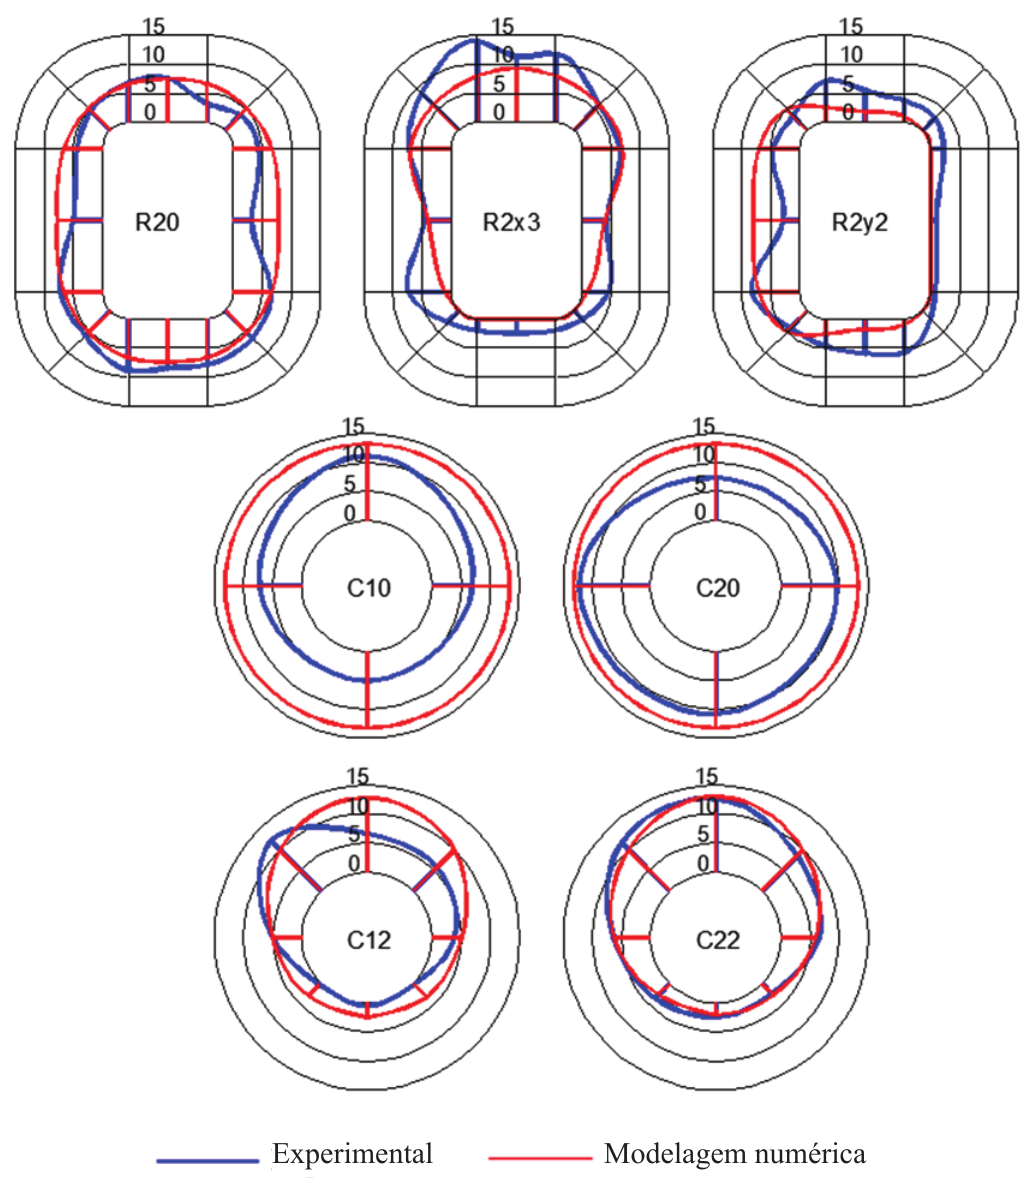
Experimental Modelagem Figura 9 Deformações no PRF ao longo do perímetro das seção intermediária dos pilares: comparação entre valores obtidos na modelagem numérica em relação aos obtidos nos ensaios experimentais por Carrazedo [17]. Séries 3 e 4 (unidades em ‰)